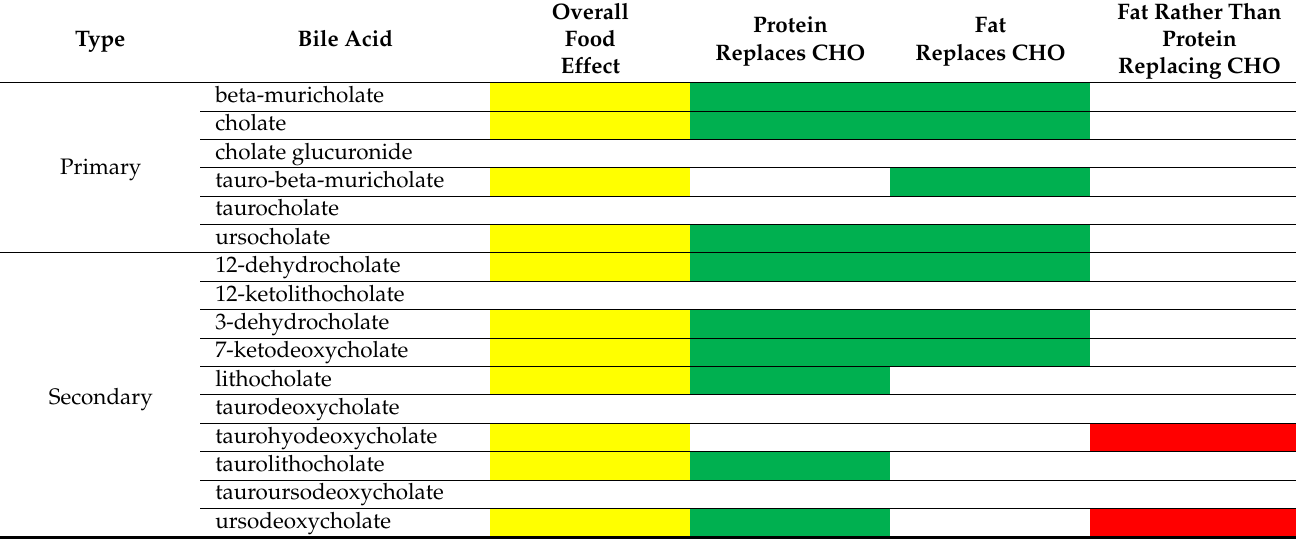
Table 14. Effects of foods on serum bile